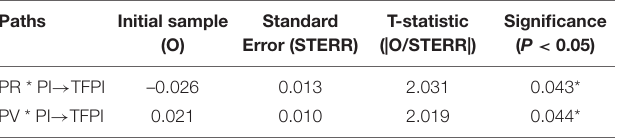
TABLE 7 | Moderating effect